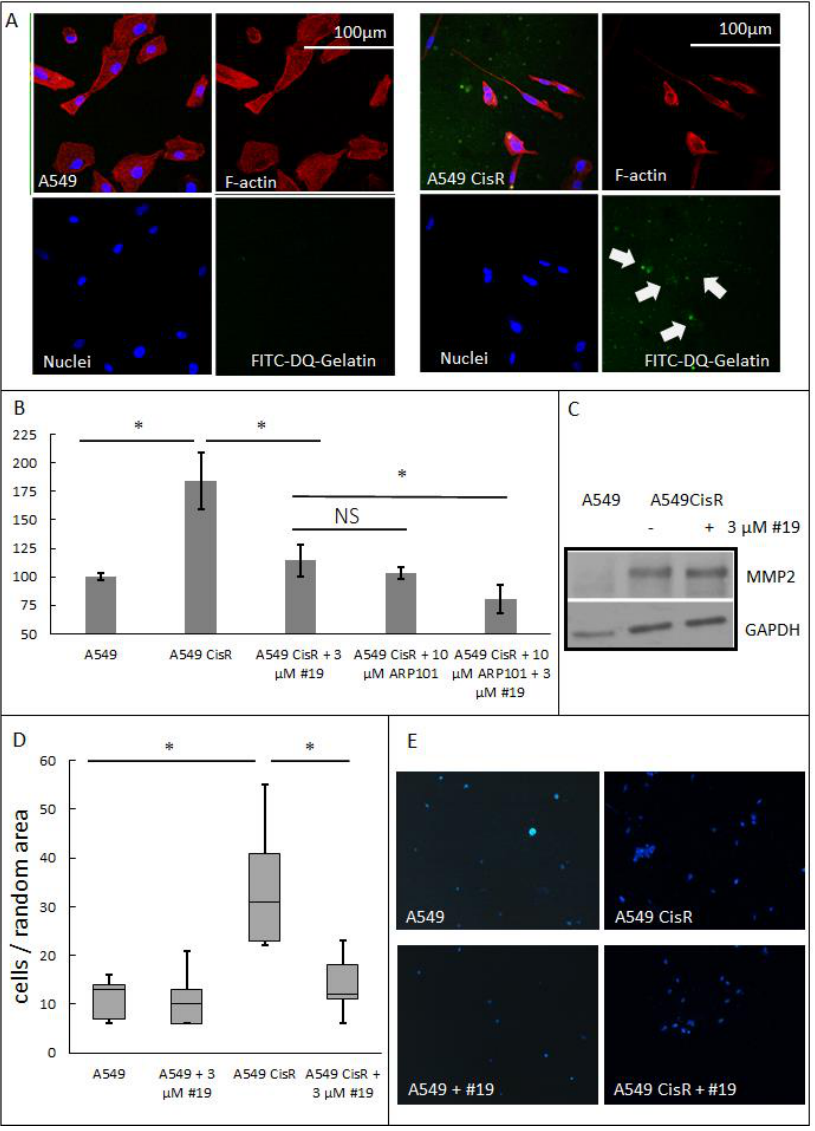
Figure 5. Repression of proteolytical and invasive abilities of A549CisR by isothiocyanates. ( A ) Con- focal microscopy image of A549 and A549CisR proteolytic degradation of FITC-conjugated DQ gel- atin (Life Technologies, Waltham, MA, USA) (zymography in situ). Cleaved DQ gelatin becomes fluorescently active as highlighted by white arrows. F-actine stained with Texas Red-X Phalloidin, nuclei stained with Hoechst 33342. ( B ) Gelatinolytic activity of A549 and A549CisR calculated by measuring fluorescence intensity of cleaved DQ gelatin. MMP2 inhibitor ARP101 used as an addi- tional control to verify ITCs impact on DG gelatin degradation. Calculated fluorescence intensity in arbitrary units of fluorescence were et as control — 100% for A549. * p < 0.05, not statistically signifi- cant — NS. ( C ) Standard SDS-PAGE Western blot analysis of MMP2 expression in A549, A549CisR, and A549CisR supplementation with compound 19 (24 h 3 µM). ( D ) Gelatin transwell invasion as- say based on [57,67]. A549 and A49CisR were treated with or without compound 19 (24 h 3 µM) and transferred to upper chamber in starving medium supplemented with or without 19 3 µM. Full medium was used as chemoattractant in lower chamber. Invasion was visualized and calculated after 3 h in 5 random spots. * p < 0.05. ( E ) Gelatin transwell invasion assay visualization by fluores- cence microscopy — random representative image.